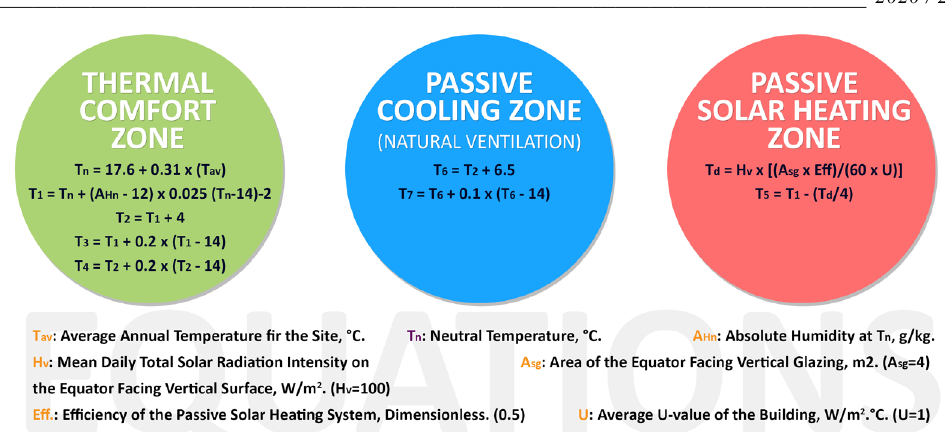
Fig. 2. Psychrometry Equations. Fig. 3 diagram describes the detailed workflow of the methodology.